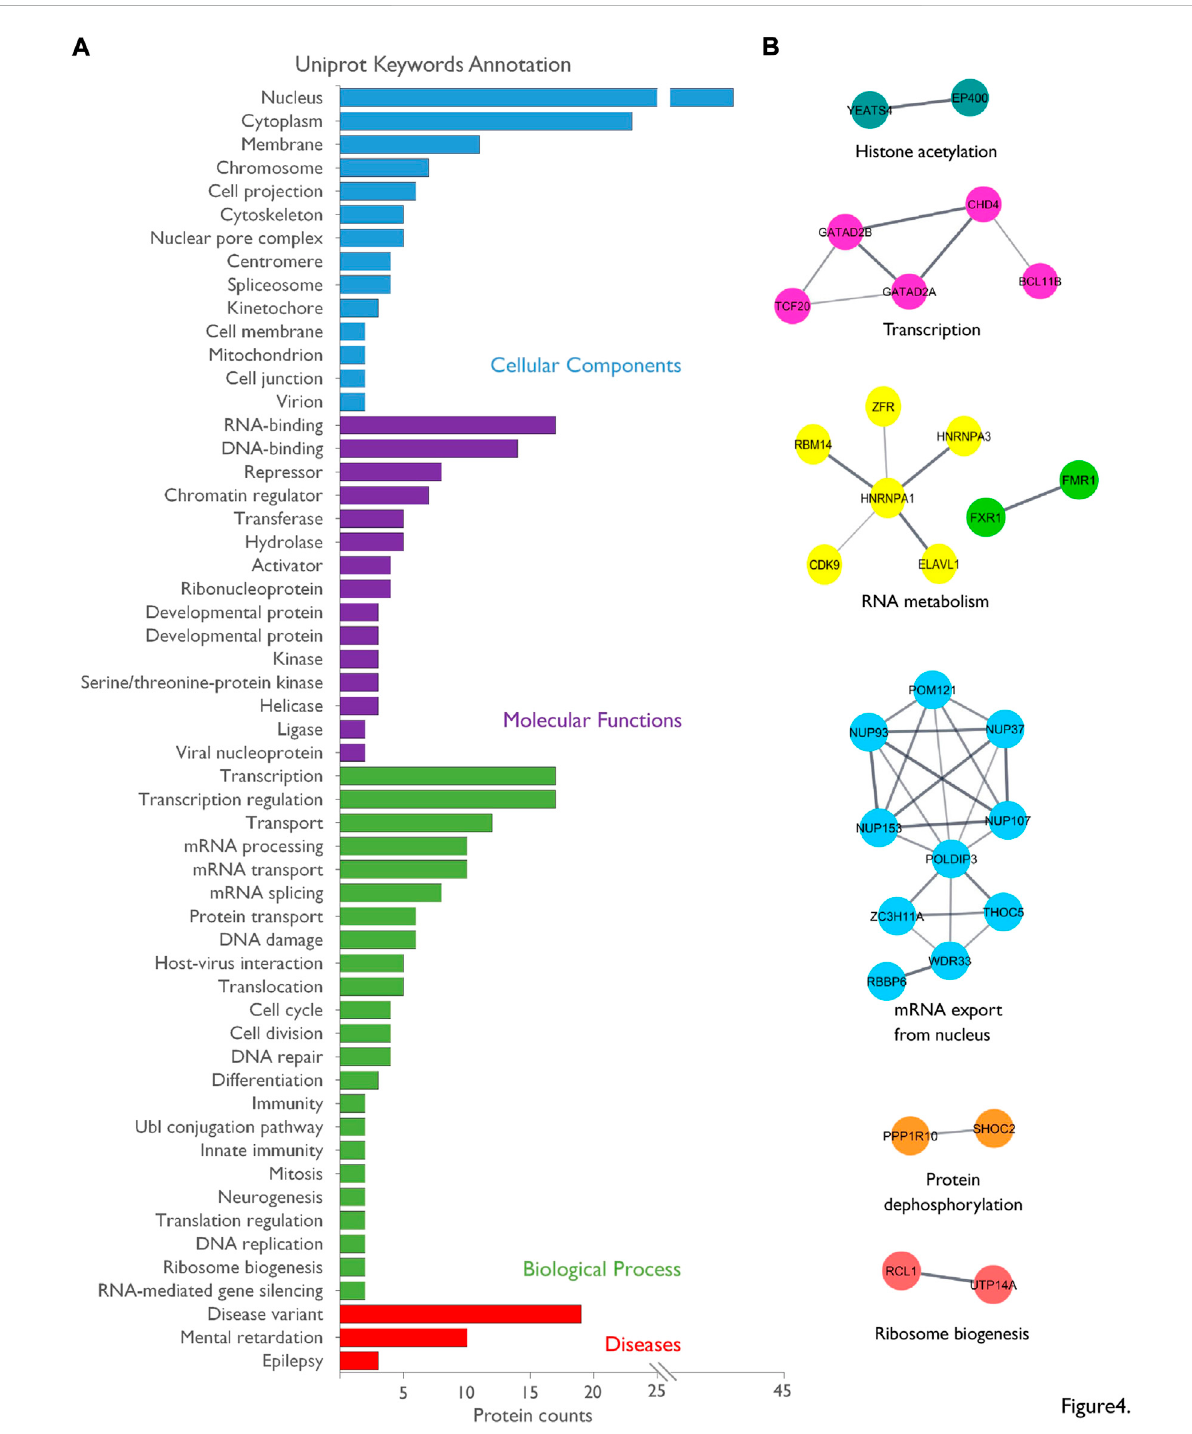
Bio-informatics analysis of the nuclear interactome of FMRP. (A) . The list of the nuclear FMRP-interacting proteins was subjected to Uniprot Keywords (UP-KW) annotation analysis using the reviewed human homologues as data source: UP-KW for Cellular Components, UP-KW for Molecular functions, UP-KW for Biological process, and UP-KW for Diseases. Terms were ranked according to the number of proteins in the category. Details are available in Supplementary Table S4. (B) A network was built on physical interaction to complexes predicted by STRING using all identi fi ed FMRP-interacting proteins candidates as source, with an interaction con fi dence of 0.4 or greater and based on databases and experiments sources. The STRING network was imported into the Cytoscape application and clusters were created and annotated through the StringApp